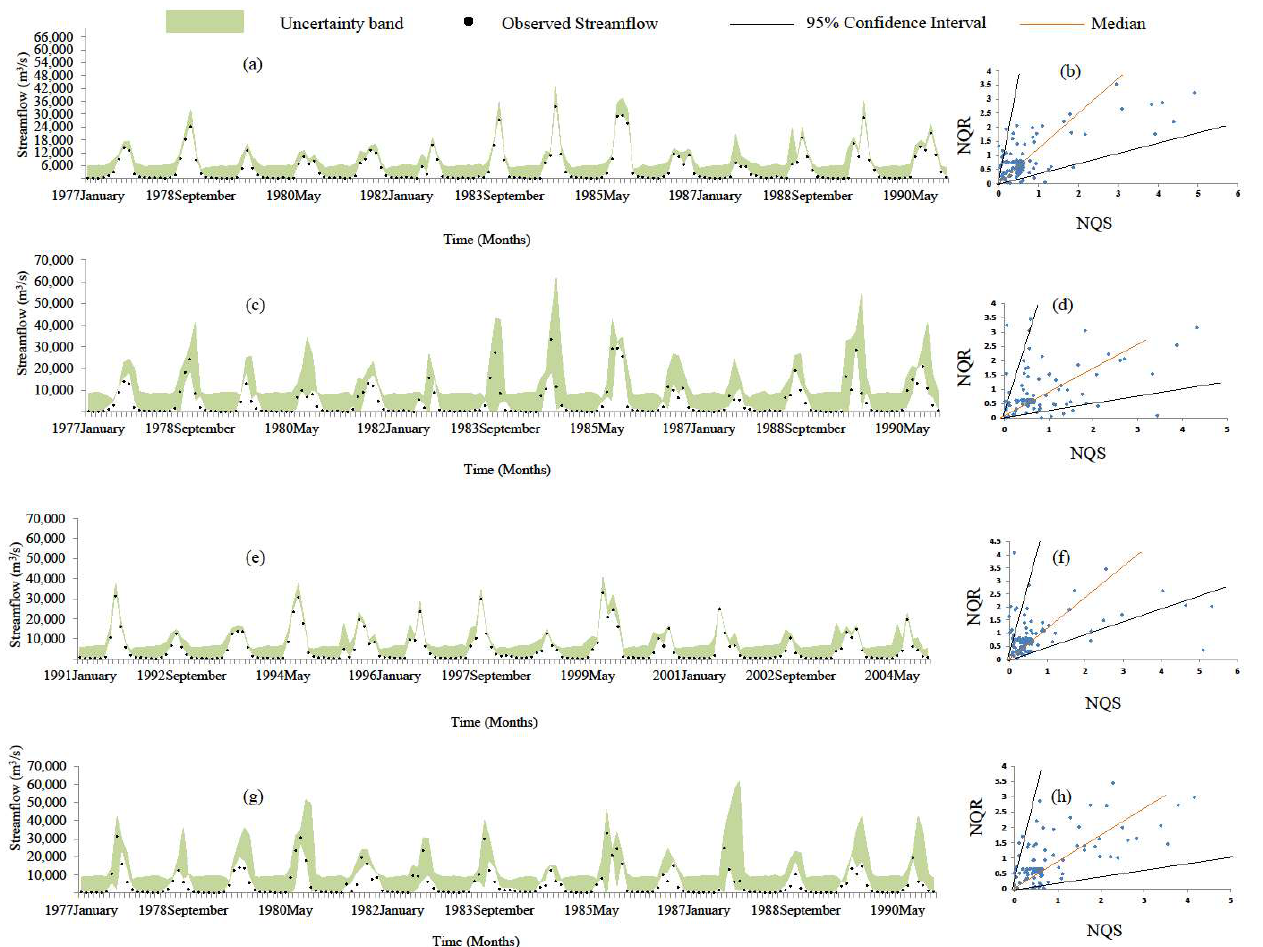
Figure 6. ( a ) Observed discharge and uncertainty band for SHM simulation for calibration period, ( b ) Error model of SHM simulation for calibration period in normalized domain ( c ) Observed discharge and uncertainty band for SWAT simulation for calibration period, ( d ) Error model of SWAT simulation for calibration period in normalized domain ( e ) Observed discharge and uncertainty band for SHM simulation for validation period, ( f ) Error model of SHM simulation for validation period in normalized domain ( g ) Observed discharge and uncertainty band for SWAT simulation for validation period, ( h ) Error model of SWAT simulation for validation period in normalized domain.